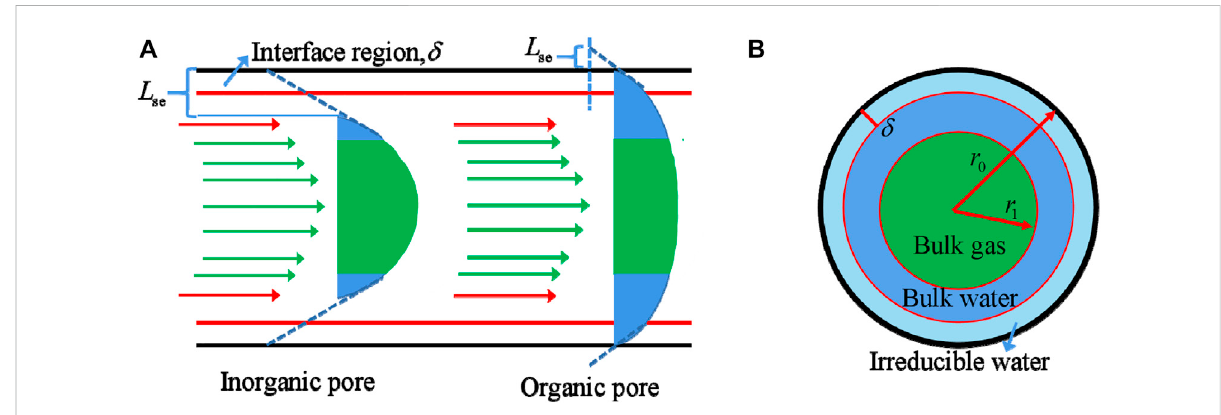
FIGURE 2 Physical model of gas and water fl uid fl ow in organic/inorganic